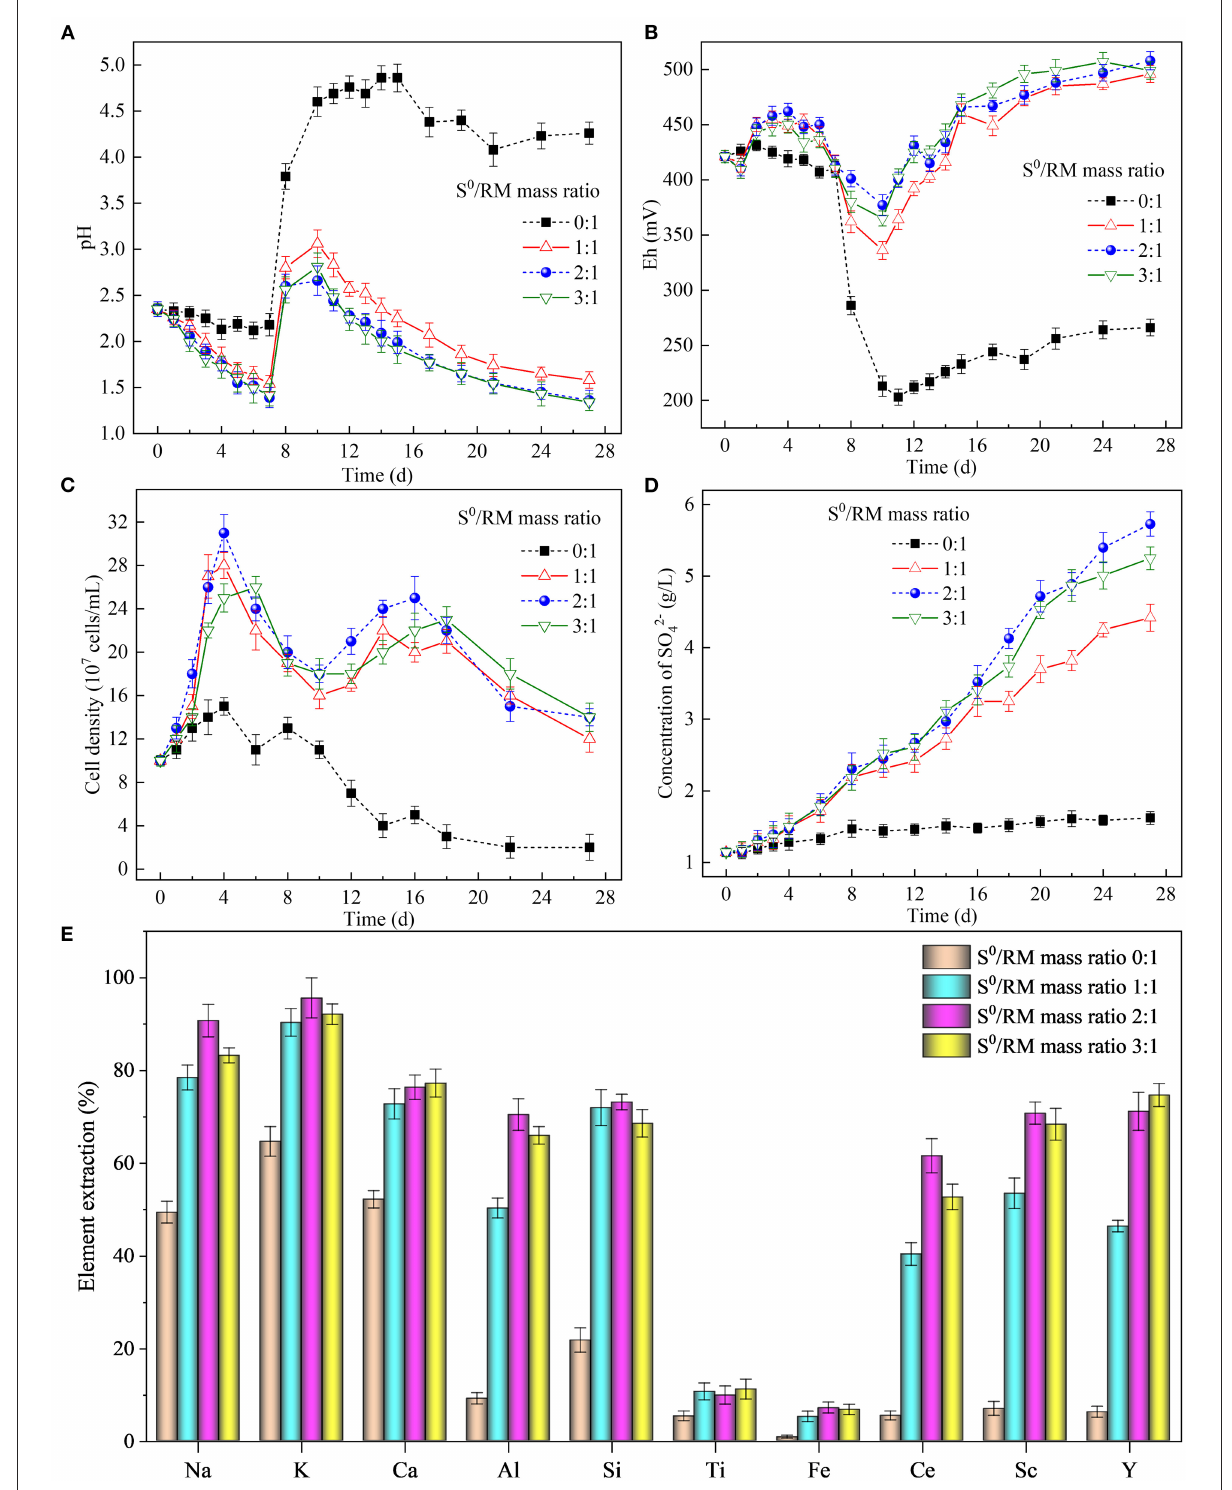
FIGURE2 Effects of the S 0 /RM mass ratio on RM bioleaching process kinetics. Changes in (A) pH, (B) Eh, (C) planktonic cell counts, (D) concentration of SO 2 − 4 during the bioleaching processes under S 0 /RM mass ratios of 0:1, 1:1, 2:1, and 3:1, and (E) percentages of elements extracted from RM into solution after 27 days of RM